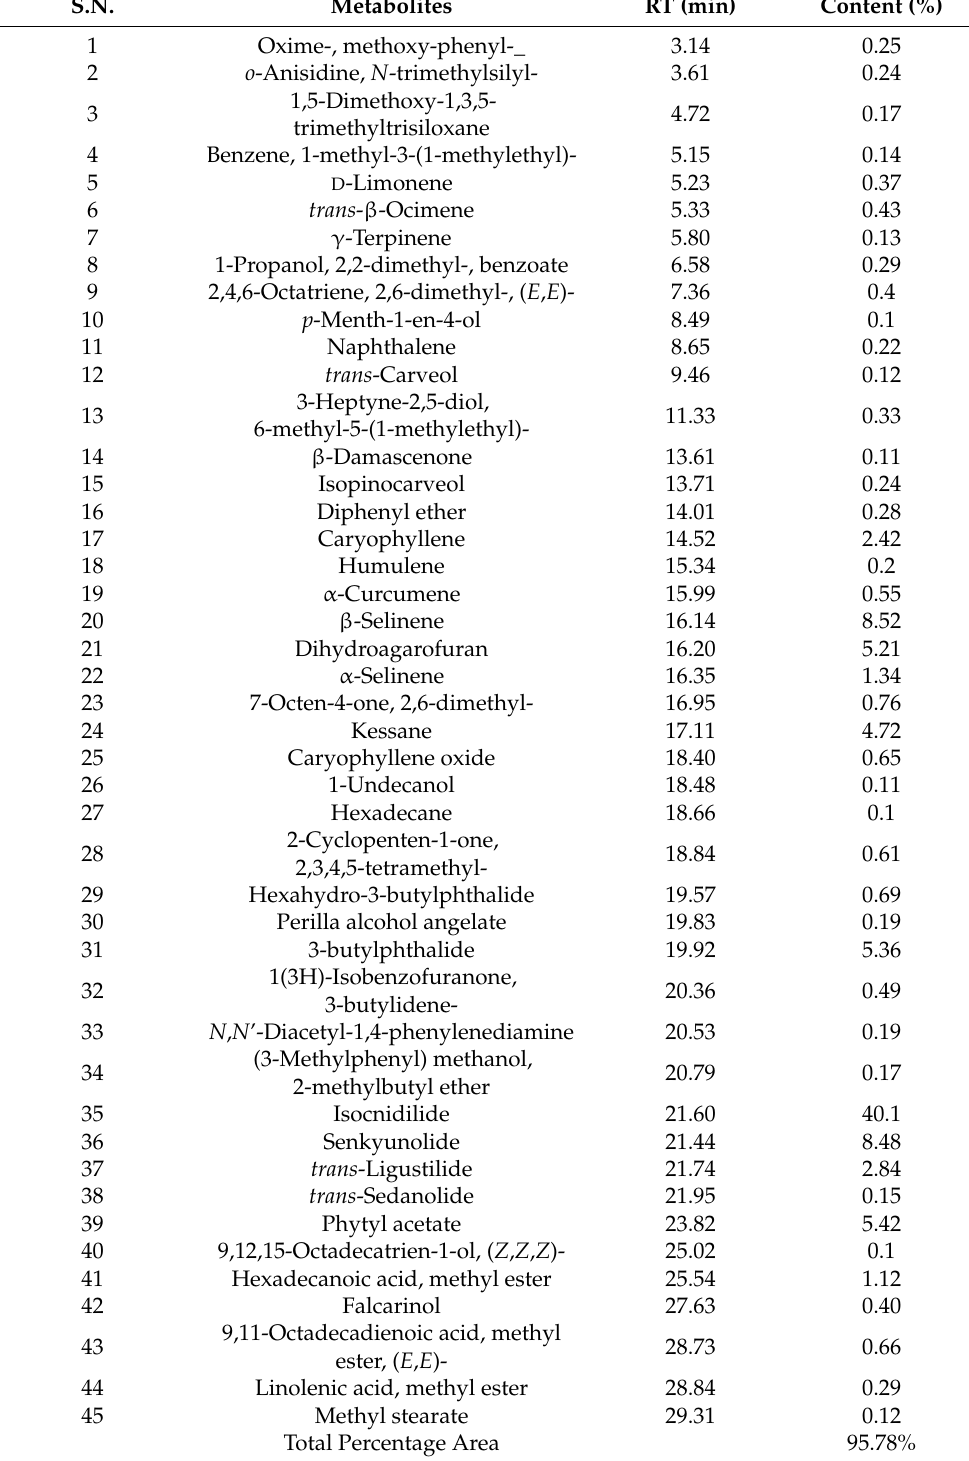
Table 1. Chemical composition of Apium graveolens oil